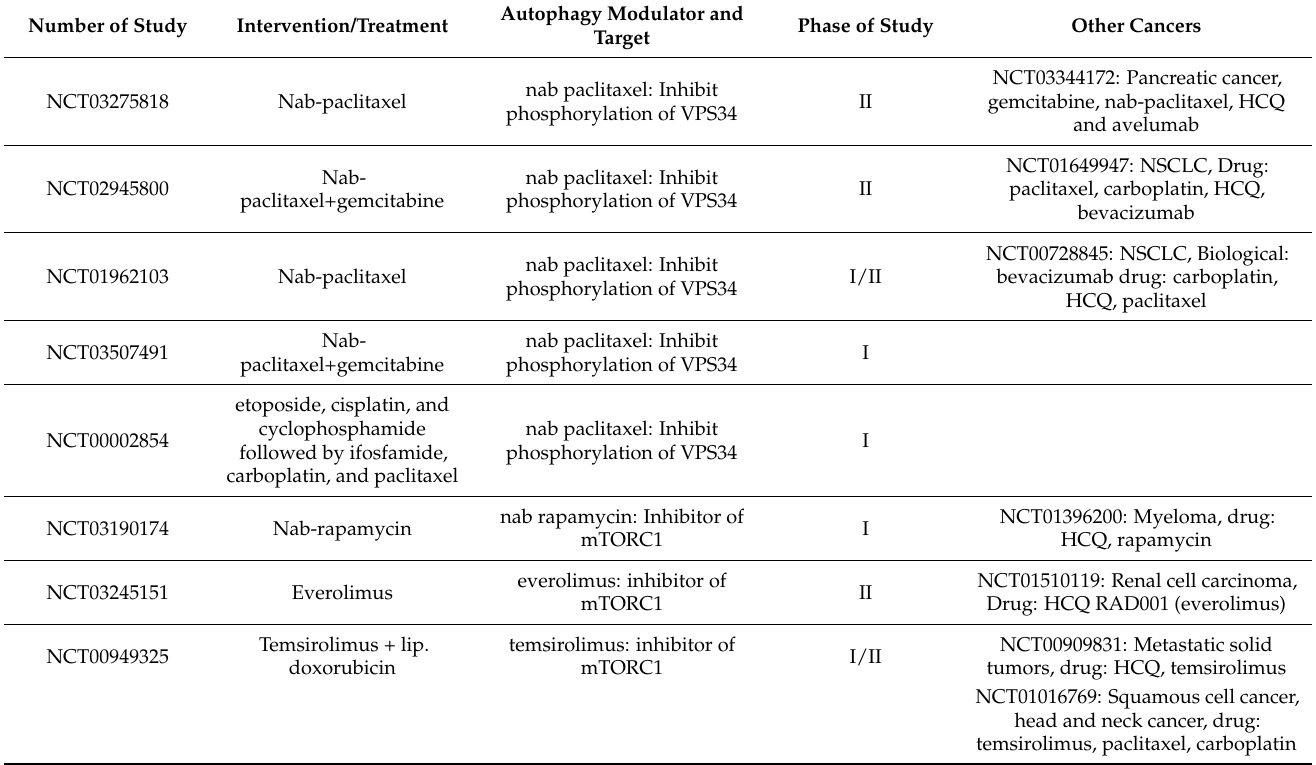
Table 1. Clinical studies with autophagy modulators for ES